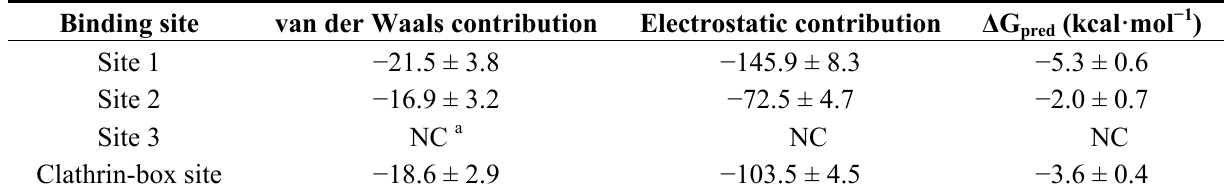
Table 2. LIE binding free energy (kcal·mol − 1 ) and its components for 1 at potential binding sites in the